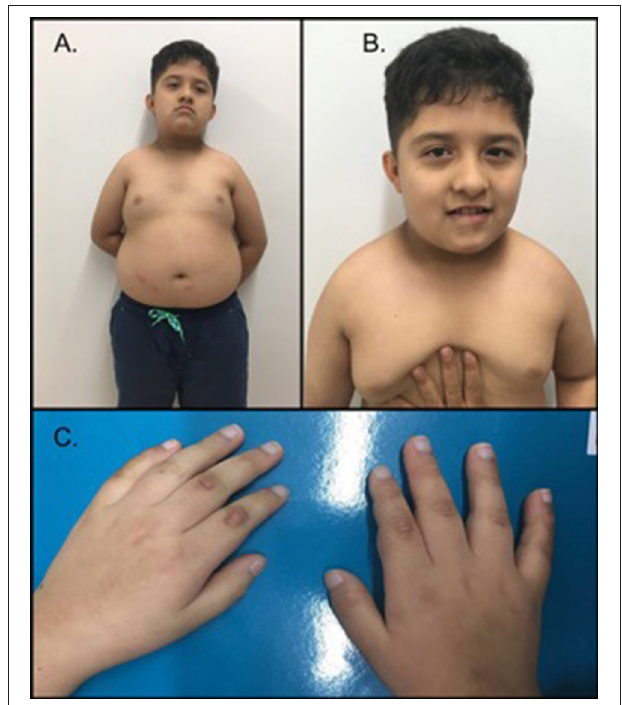
FIGURE 1 | Phenotype of the patient. (A) The patient exhibited a short neck, brachycephaly, acanthosis nigricans on the nape of the neck, central abdominal obesity and gynecomastia. (B) Facial features demonstrated synophrys, facial asymmetry, downward slanting palpebral fissures, a broad nasal bridge and a thin upper lip. (C) Hands of the proband; note the short and thick fingers. The patient’s parents provided written informed consent for the publication of his